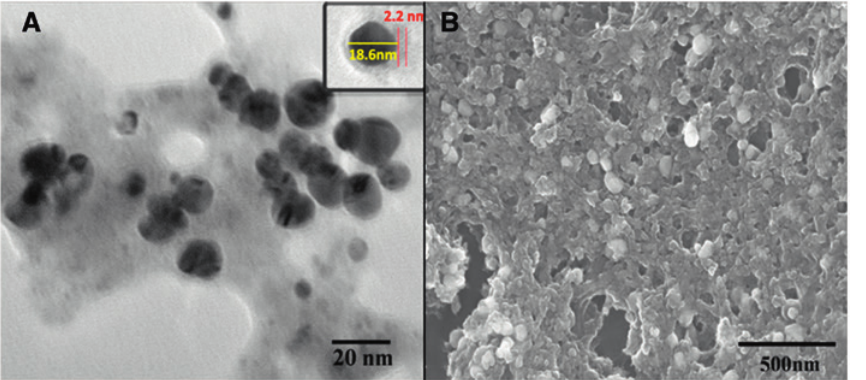
Figure 2: (A) transmission electron microscopy (TEM) and (B) scanning electron micmroscopy (SEM) images of silver nanoparticles (AgNPs) clearly demonstrating the nanoscale size and plant extract coating over NPs.